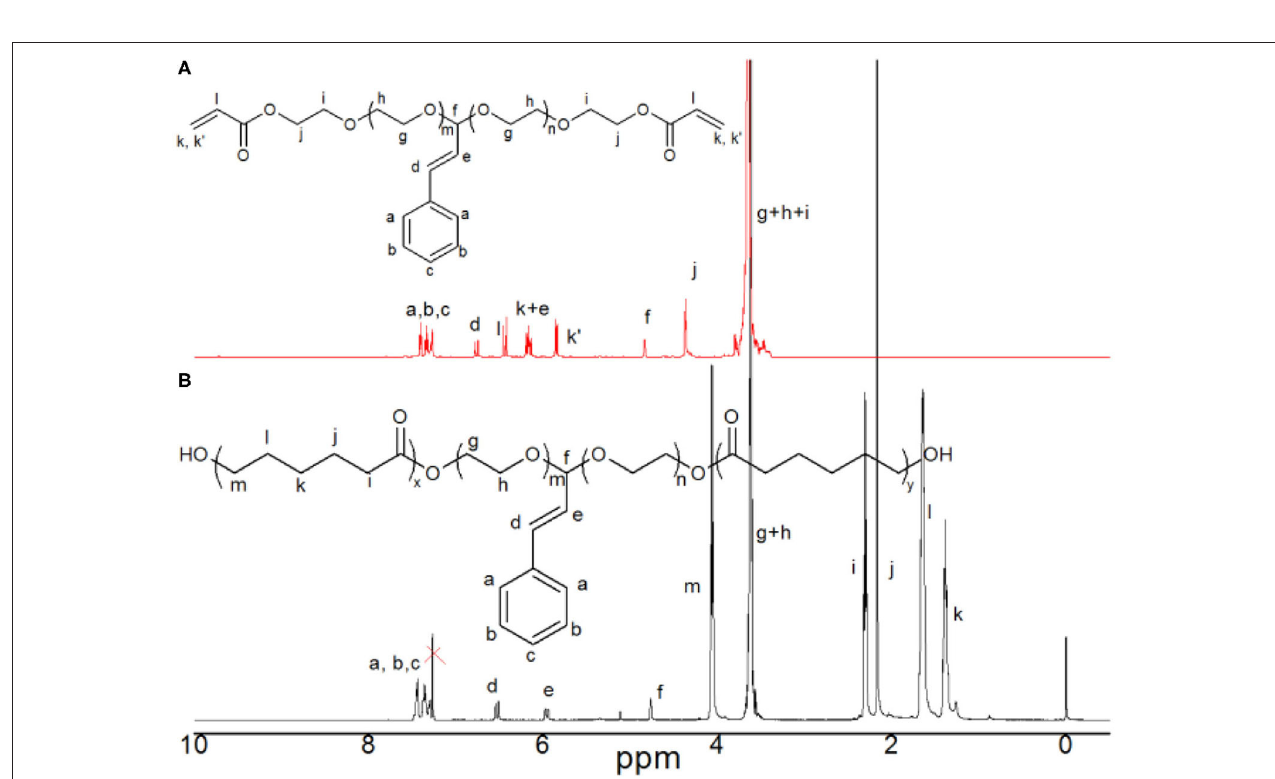
FIGURE 4 | 1 H NMR spectra of acrylate-PEG(ca)-acrylate (A) and triblock copolymer HO-PCL-b-PEG(ca)-b-PCL-OH (B) in CDCl 3 .